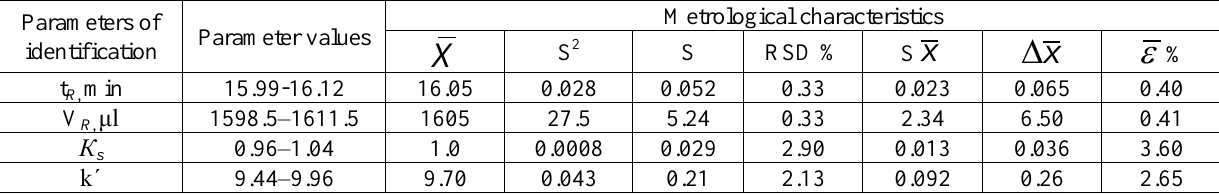
Parameters of retention, coefficients of the symmetry of the peaks and coefficients of capacity ratio of prazosin hydro-